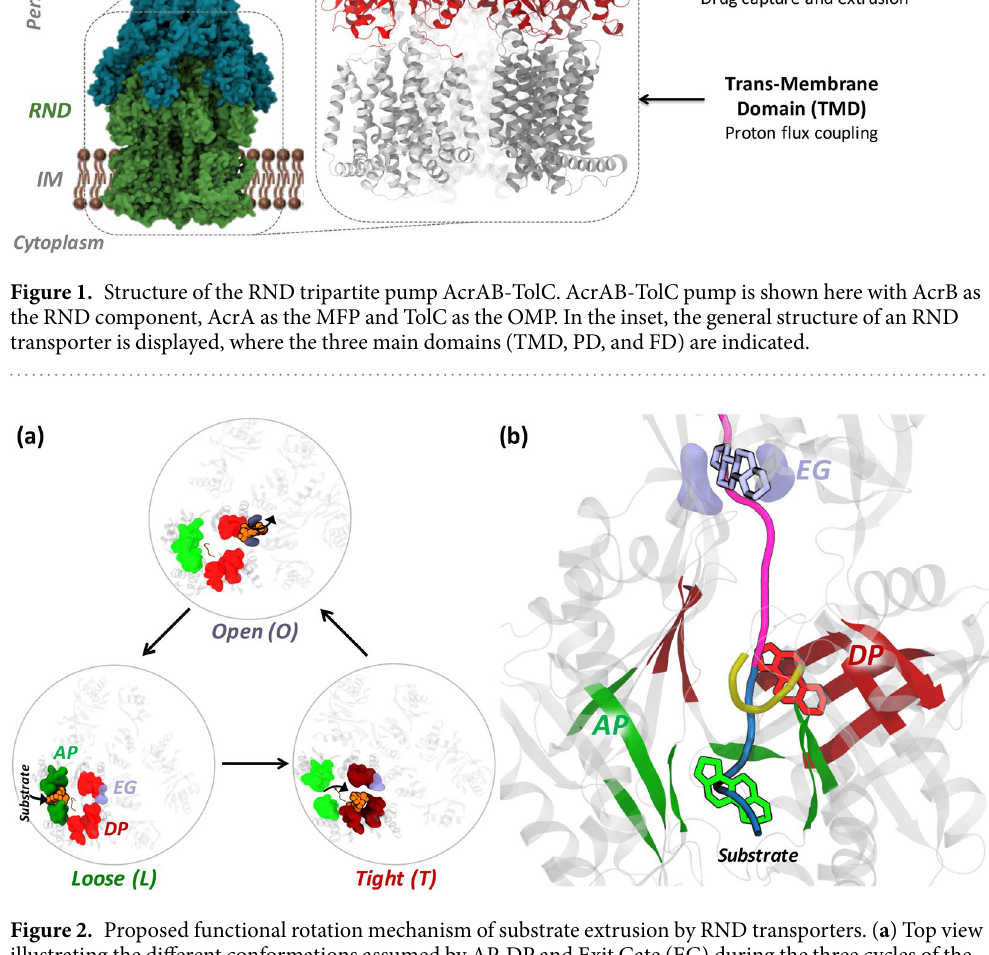
(Fig. 2) in which concerted but not necessarily synchronous cycling of the protomers occurs through any of the so far identified asymmetric states: Loose ( L ) (a.k.a. Access ) in which substrates bind to a peripheral site named access pocket (AP); Tight ( T ) (a.k.a. Binding ) in which substrates bind to a more deep pocket (DP); and Open ( O ) (a.k.a. Extrusion ) in which the substrate is released into the central funnel leading towards the OMP 14, 20, 21 . The two pockets (Fig. 2) were previously identified in AcrB as the binding sites responsible for the recognition and selectivity of different molecules 15, 22–24 . Namely, the AP and DP have been hypothesized to be responsi- ble for the recognition of high-molecular-mass and low-molecular-mass compounds, respectively 15 . They are separated by a G-rich (a.k.a. switch) loop whose flexibility has been shown to be important for the transport of high-molecular-mass molecules 15, 16 .